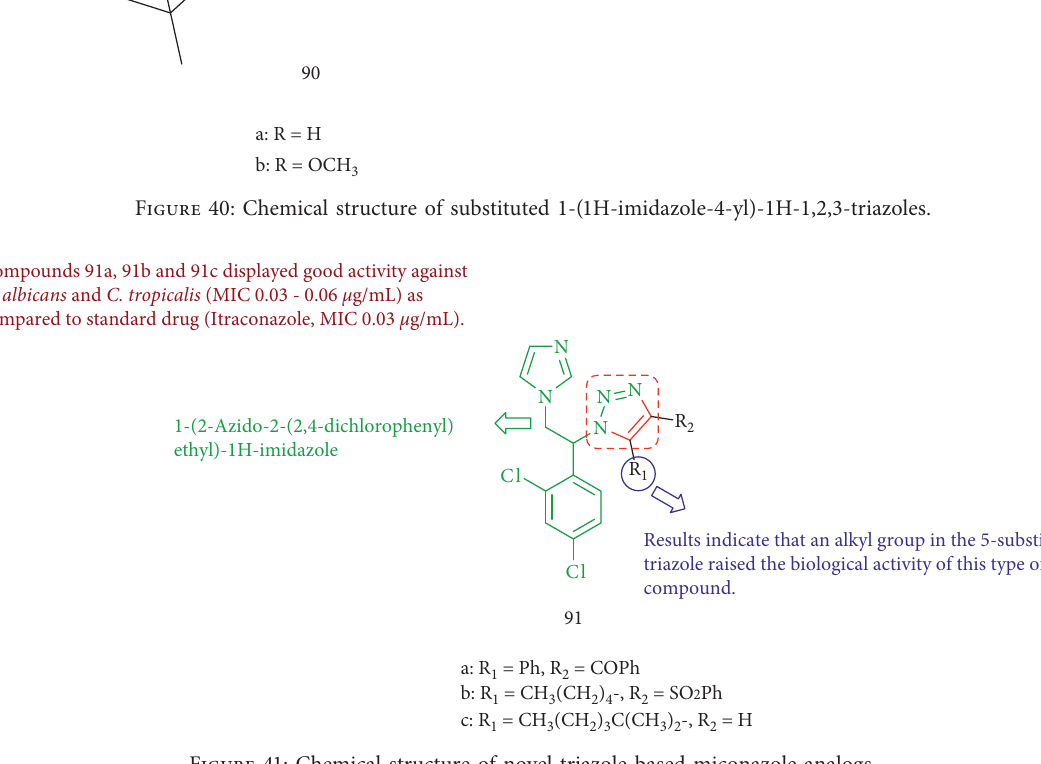
Figure 41: Chemical structure of novel triazole-based miconazole